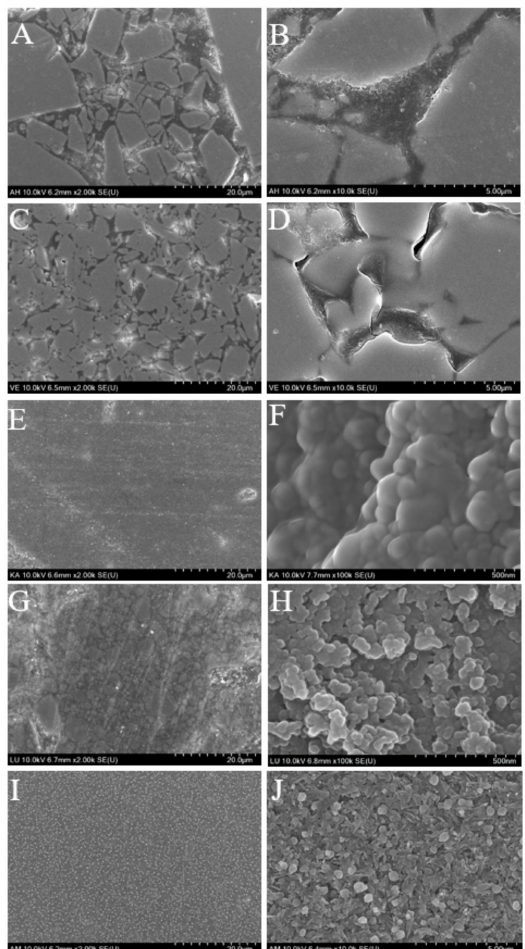
Figure 7. SEM images of the five tested materials after toothbrushing: ( A , B ): AH; ( C , D ): VE; ( E , F ): KA; ( G , H ): LU; ( I , J ):